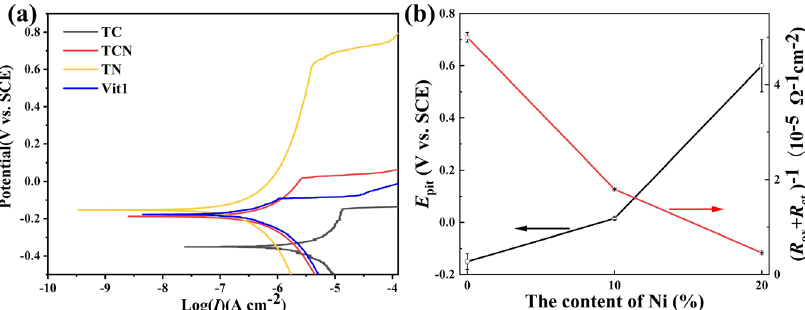
Fig. 2 Potentiodynamic polarization test results of the four samples in 3.5 wt. % NaCl at 298 K. a Polarization curves ( b ) Corrosion resistance (in terms of the pitting potential and ( R ox + R ct ) − 1 ) as a function of the Ni content.